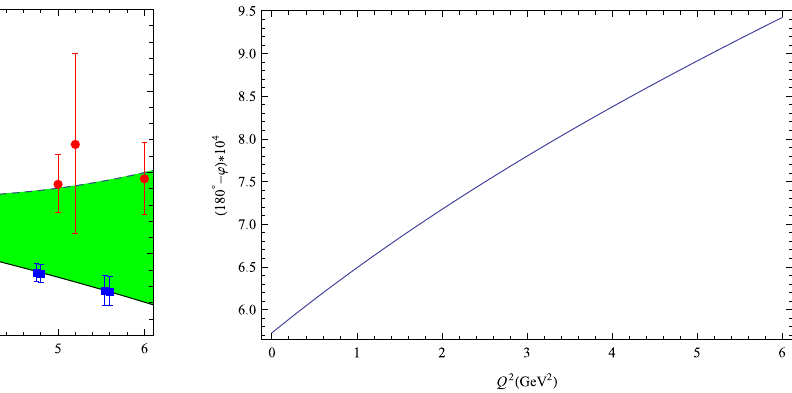
Fig. 3 Scattering angle verses transferred momentum ( Q 2 ) in NCST, taking (cid:2) NC = 1 TeV and ε = 10 − 11 , occurred at ϕ ∼ 180 ◦ . As can